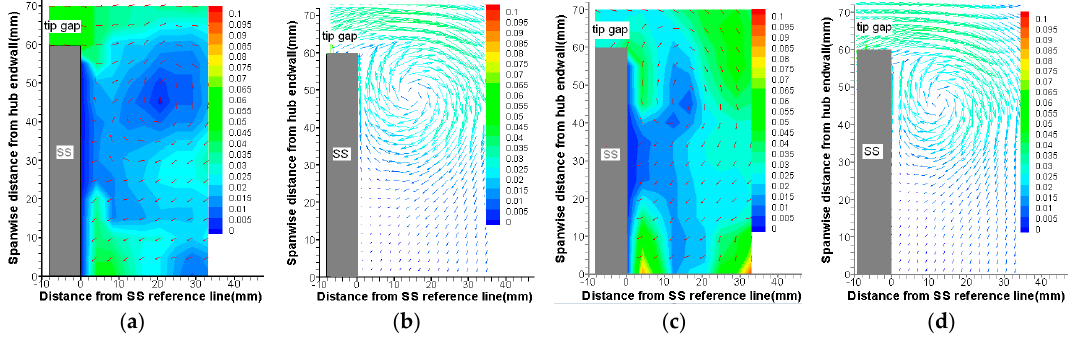
Figure 5. Mean velocity distributions on cuts 1 and 2 (m/s): ( a ) Cut 1-experiment; ( b ) Cut 1-simulation; ( c ) Cut 2-experiment; ( d ) Cut 2-simulation.